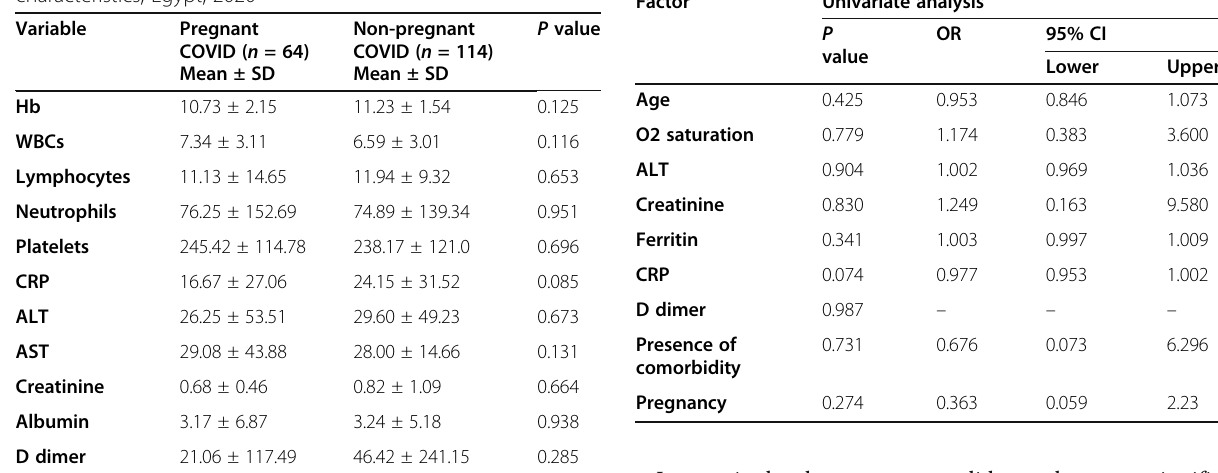
Table 2 Comparison between the pregnant COVID-19 and non- pregnant COVID-19 patients regarding their laboratory